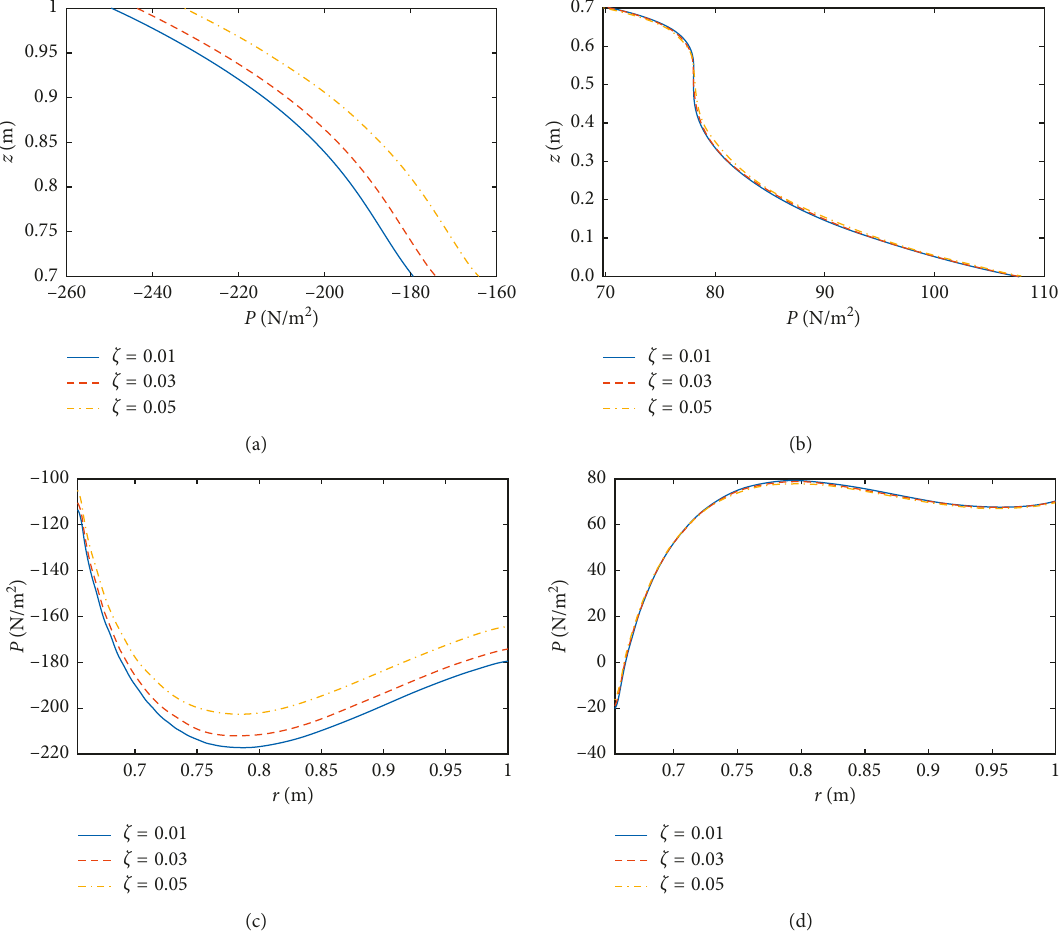
Figure 11: The pressure distributions on the tank wall and baffle at θ � 0 when ω pressure distribution of the tank wall above the baffle, (b) The pressure distribution of the tank wall below the baffle, (c) The pressure distribution acting on the upper surface of the baffle, (d) The pressure distribution acting on the lower surface of the